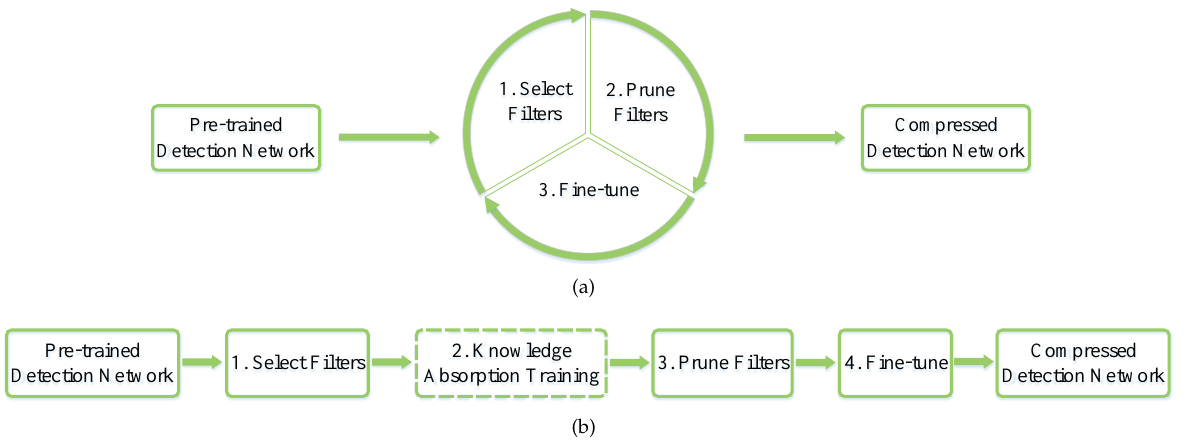
Figure 1. Comparison between the pipeline of the absorption pruning algorithm proposed in this paper and the pipeline of the traditional pruning algorithm: ( a ) Pipeline of the classic pruning method, and ( b ) pipeline of the absorption pruning